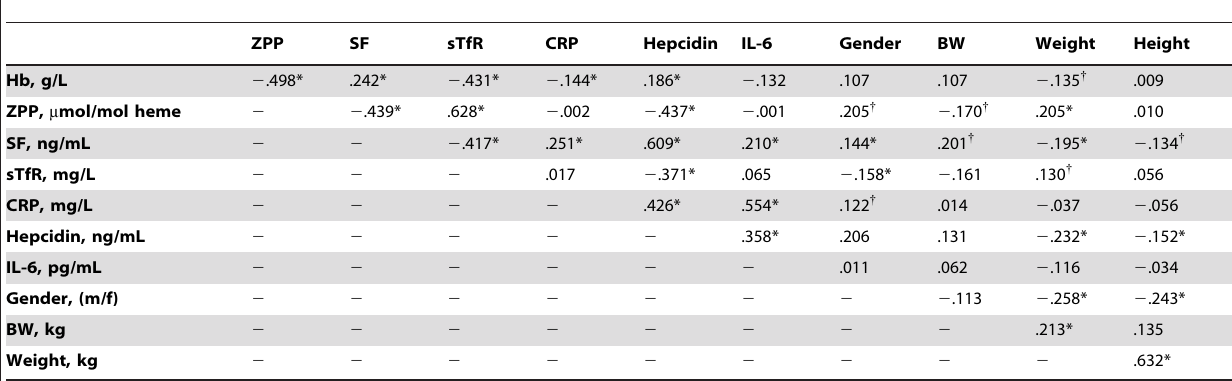
Table 2. Spearman correlation coefficients (rho) from iron and inflammation markers and anthropometric data of the study infants.